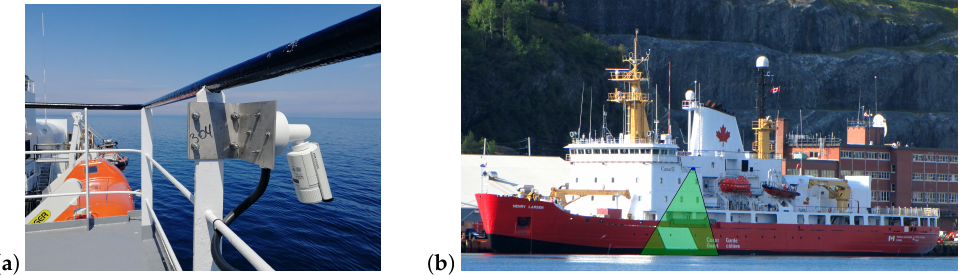
Figure 5. Railing support and positioning of the camera ( a ); view angle on the sea surface ( b ).